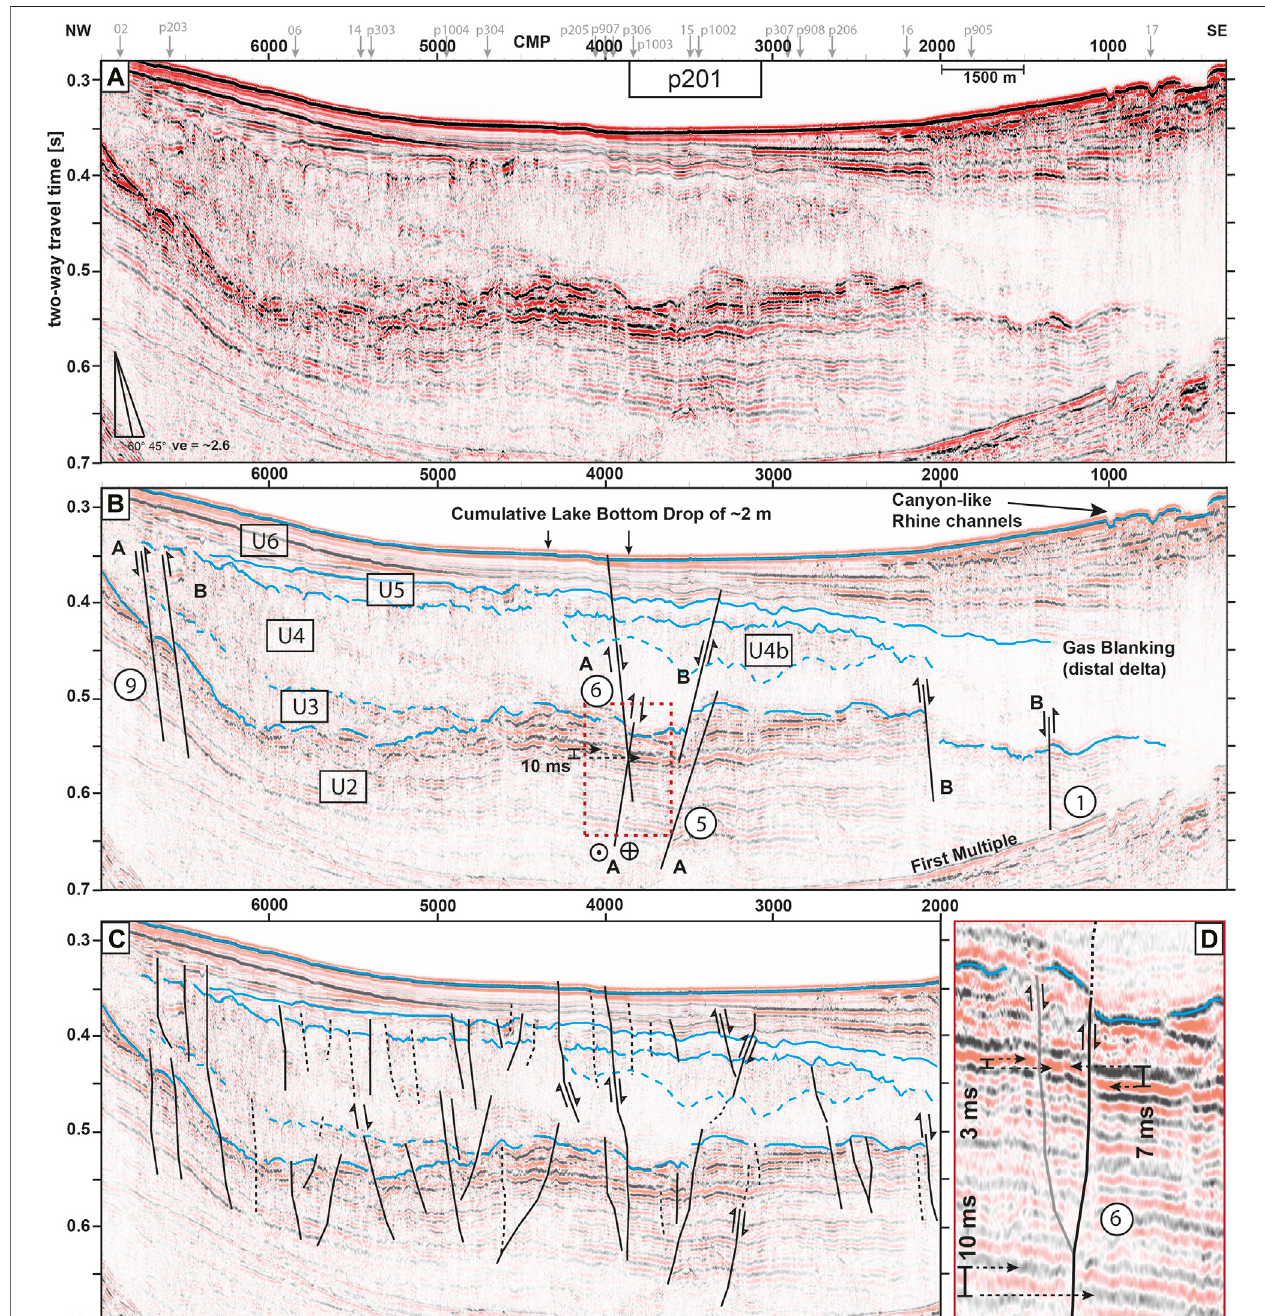
FIGURE 9 | (A) : Multi-channel re fl ection seismic section p201 (vintage 2017) with two different fault interpretations (B, C) of the same seismic section (location in Figure 3 ). (B) : Simpli fi ed fault interpretation based on speci fi c picking criteria with quality factor (A to C, Supplementary Table S4 ) and fault identi fi er (FID, circled number) for faultplanes. (C) : “ Pushy ” fault interpretation, motivated by strong vertical exaggeration, not used for further analysis. (D) : A zoomed version of the Molasses bedrock-sediment interface (extent marked in B) highlighting a vertical cumulative offset of Molasse re fl ections of 10 ms along the Kippenhorn Fault (FID 6 at this level constituted by 3 ms (grey) and 7 ms (black) along a northwestern and a southeastern branch respectively).